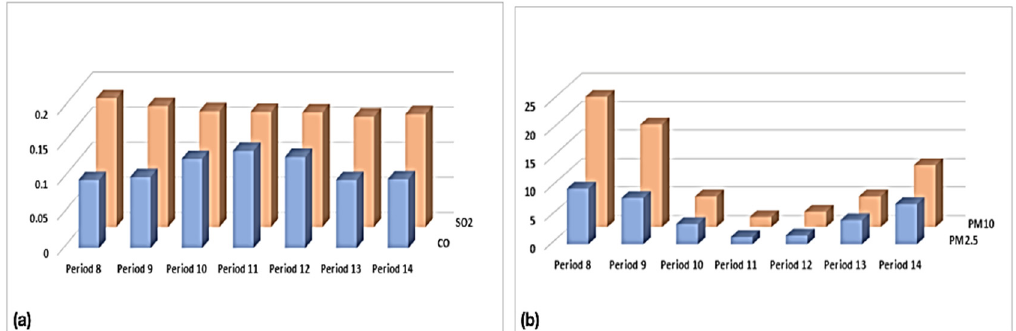
Figure 12. ( a ) Gas and ( b ) particulate pollution levels comparison in Santiago de Los Caballeros from period 8 to 14.